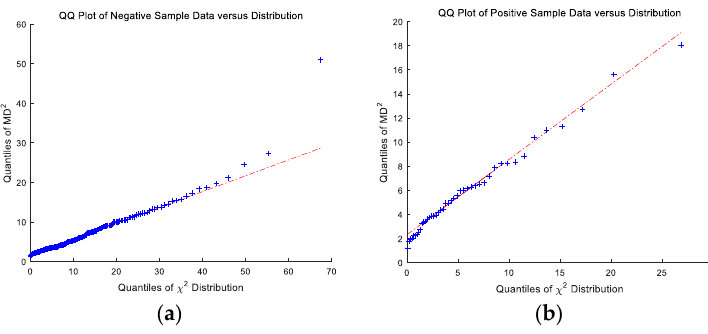
Figure 4. ( a ) QQ-plots of 𝑀𝐷 2 and 𝒳 2 distribution for the negative sample; ( b ) QQ-plots of 𝑀𝐷 2 and 𝒳 2 distribution for the positive sample.